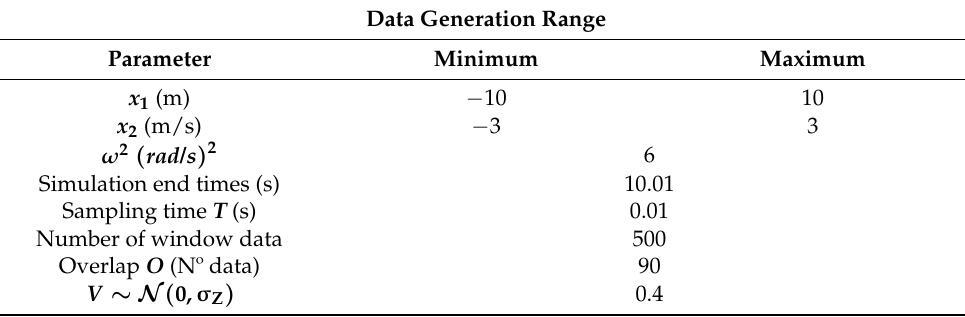
Table 1. Synthetic data generation parameters: sinusoidal